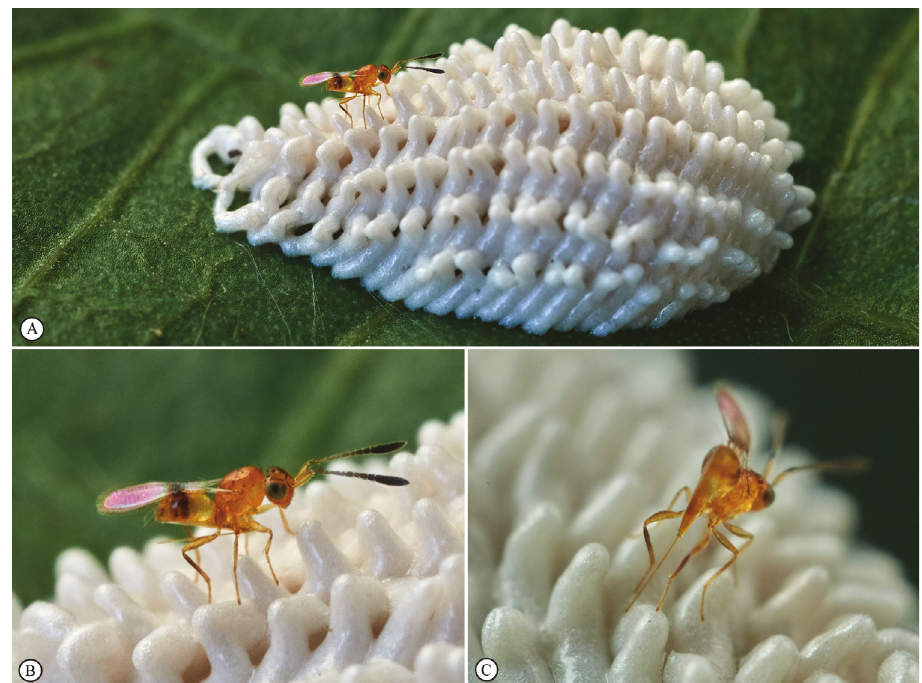
Figure 5. Gastrogonatocerus membraciphagus . The photographs (courtesy of Paul Bertner) were taken at the Sani Lodge Prinicipal, Río Napo, Yasuní, Orellana, Ecuador, in January 2018. A Female (in lateral vew) on an egg mass of a treehopper (Membracidae), similar in appearance to a Bolbonota sp. B Same female (in close-up) C Same female (in rear view) ovipositing in that egg